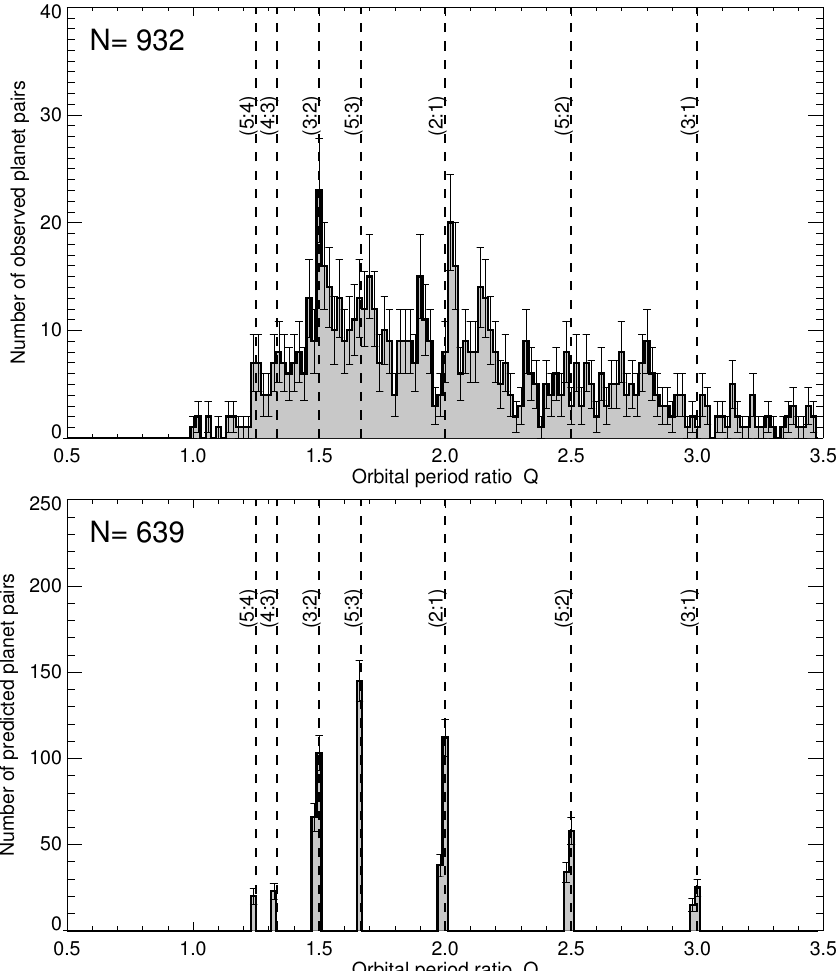
Figure 1. Top : The distribution of orbital period ratios Q in all 932 cases of planet pairs measured in the exoplanet database, using the version from 10 May 2017, contains confirmed planets as well as candidate planets from the Kepler mission. The error bars conform to Poisson statistics. The seven principal harmonic ratios are marked with vertical dashed lines. Bottom : The predicted quantized distribution of orbital period ratios Q in complete (gap-free) sequences of exoplanet detections (with at least three detections), obtained after filling gaps with Q > 3.0 using the search strategy described in Section